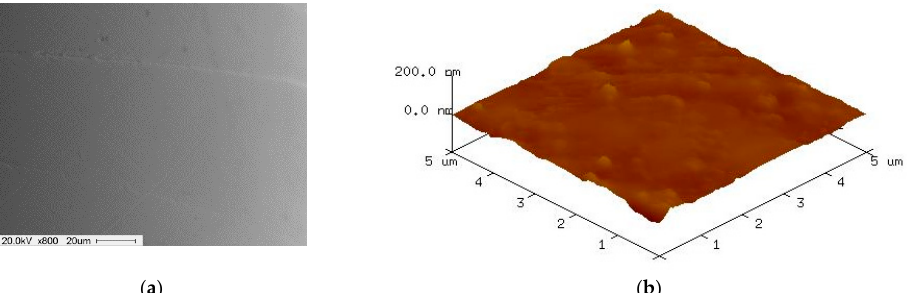
Figure 10. SEM and AFM surface images of 316L stent wire after finishing by ecological magnetic abrasive tools (Ra: 0.06 µm, 1200 rpm, 10 Hz). ( a ) SEM surface image after finishing; ( b ) AFM surface image after finishing.